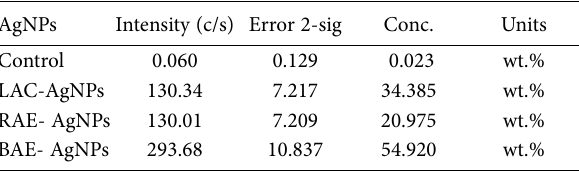
Table 2. EDS reported from biosynthesized AgNPs. AgNPs Intensity (c/s) Error 2-sig Conc. Units